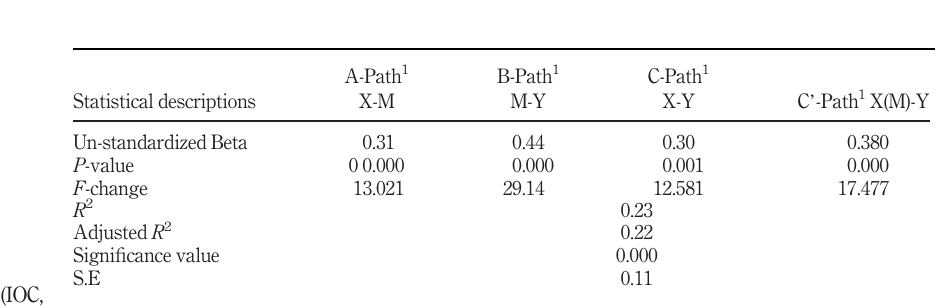
Statistical descriptions